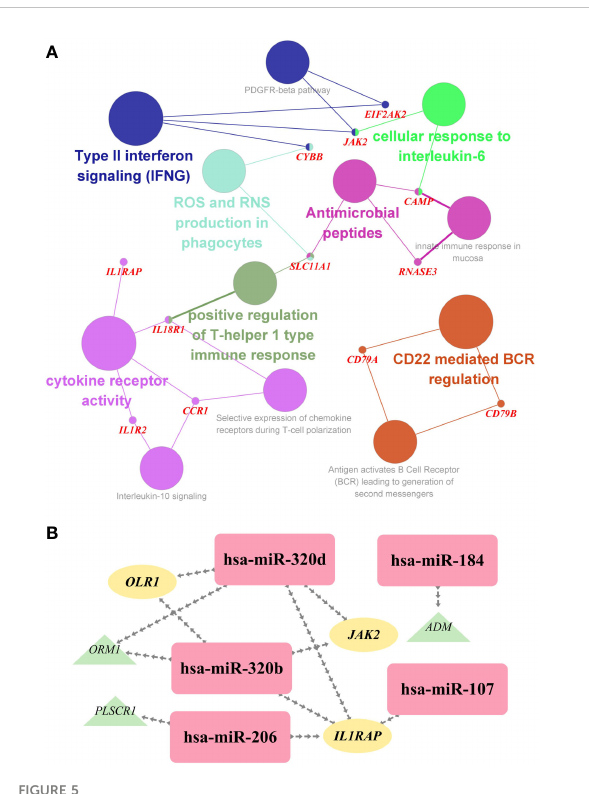
FIGURE 5 (A) The interaction network of GO terms in the common IDEGs presented by the Cytoscape plug-in ClueGO. The most signi fi cant term in each group is highlighted. (B) The miRNA-mRNA interaction network comprises the common DEGs and corresponding miRNAs. Yellow ellipses represent the hub gene; green triangles represent the common IDEGs; purple diamonds represent the corresponding miRNA